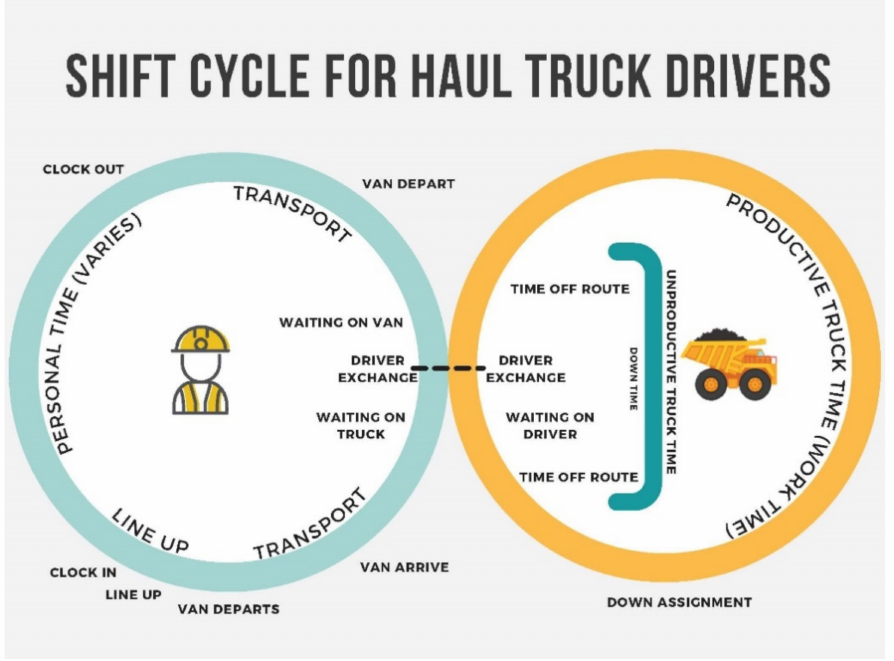
Figure 1. Shift cycle for haul truck drivers